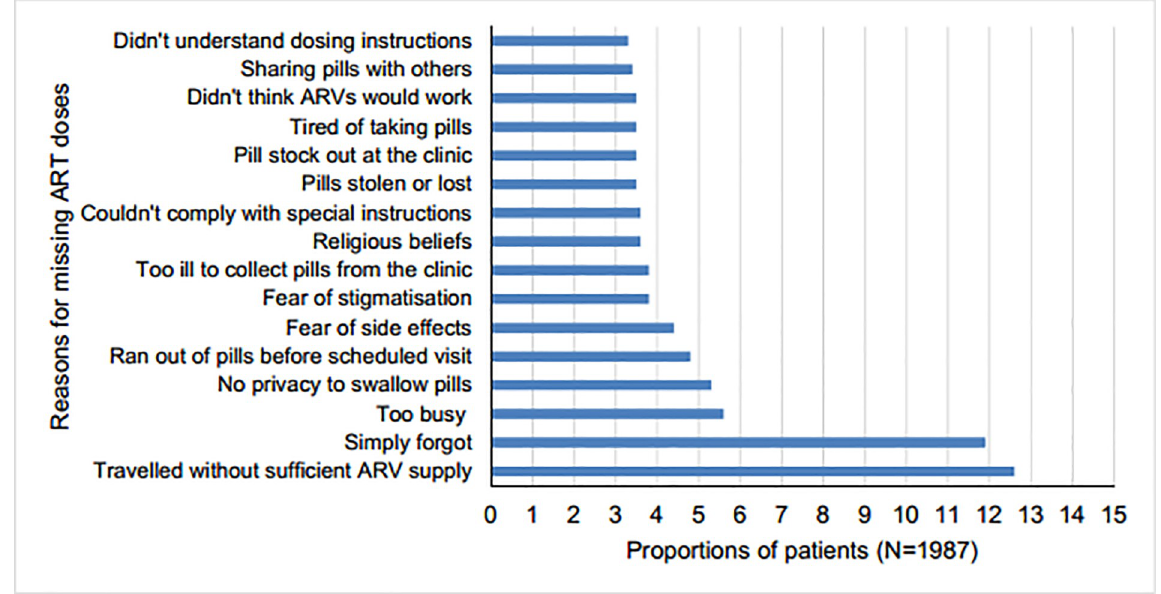
Fig 2. Reasons for missing ART